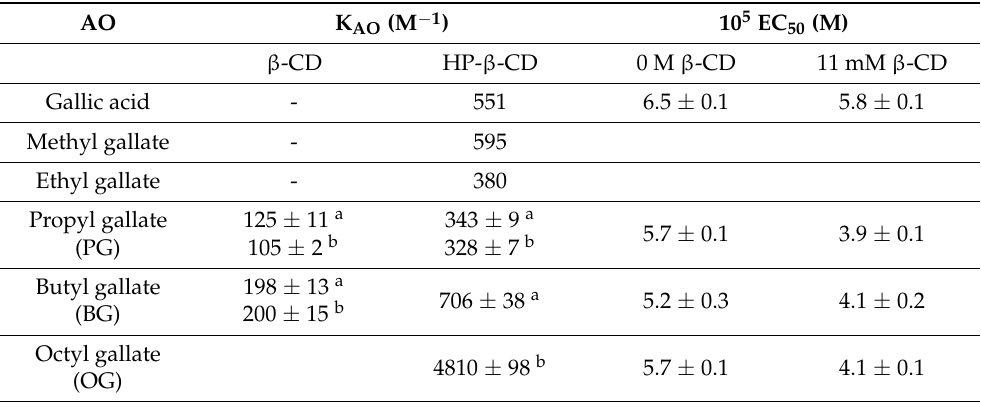
Table 6. Inclusion constants K AO for gallates and values of the concentration of gallates required to reduce the DPPH • radical concentration by 50% (EC 50 value)